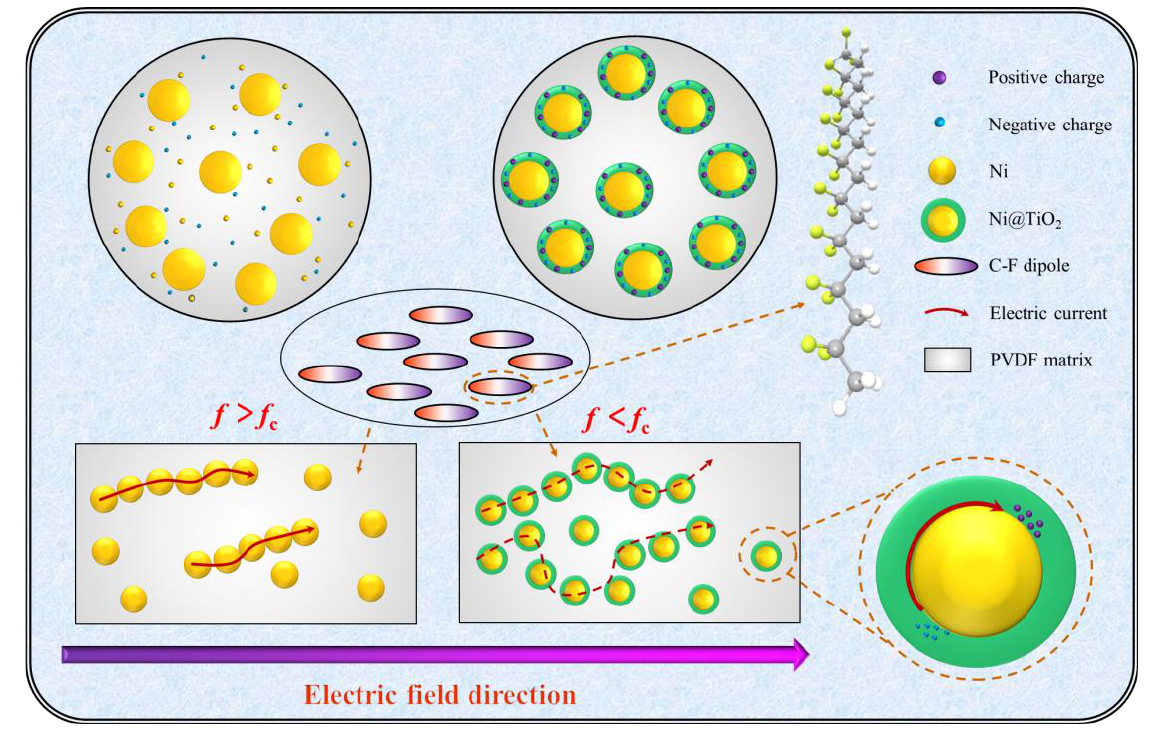
Figure 8. The brief diagrammatic drawing of the conductive network and the influence of the TiO 2 interlayer on dielectric performances of composites. interlayer on dielectric performances of